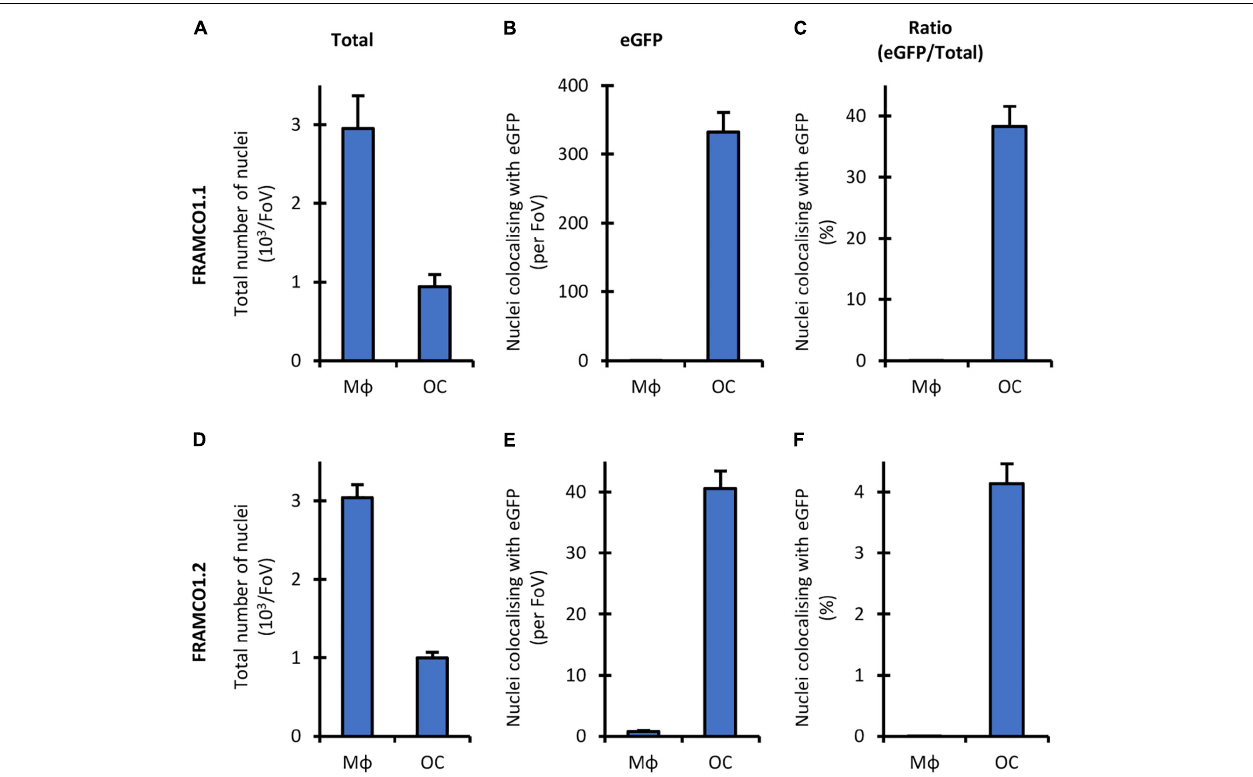
FIGURE 10 | Nucleus-based quantification of the FRAMCO1.1 and 1.2 assays. Total number of nuclei (A,D) , nuclei localized within above-threshold eGFP + objects (B,E) and the latter value as percentage of the former (C,F) in Hoechst-stained Ctsk-Cre/mTmG mono- (FRAMCO1.1, A–C ) or Ctsk-Cre + mTmG co-cultures (FRAMCO1.2, D–F ) of macrophages (M (cid:56) ) or osteoclasts (OC) stained and imaged on Day 4. Mean and SEM of five independent experiments is